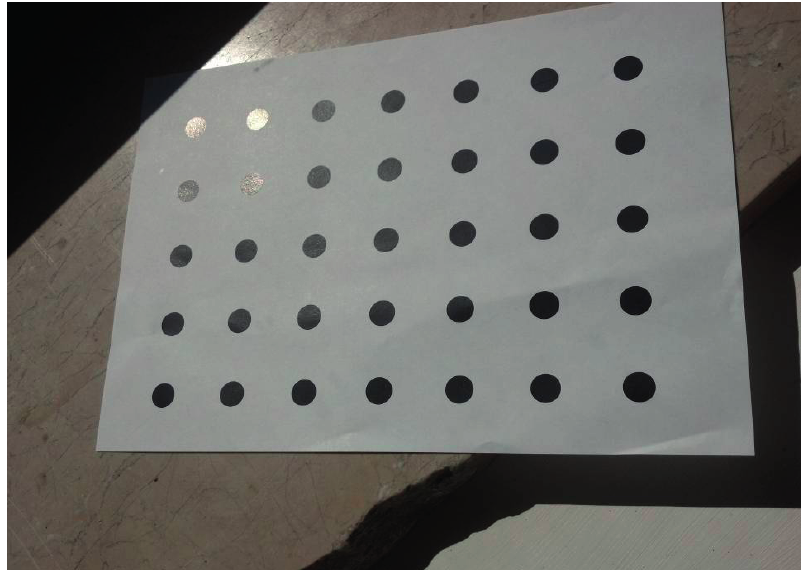
Figure 5. The gloss effect on the top left corner of the calibration field is giving brighter colors to some circles of the calibration field.